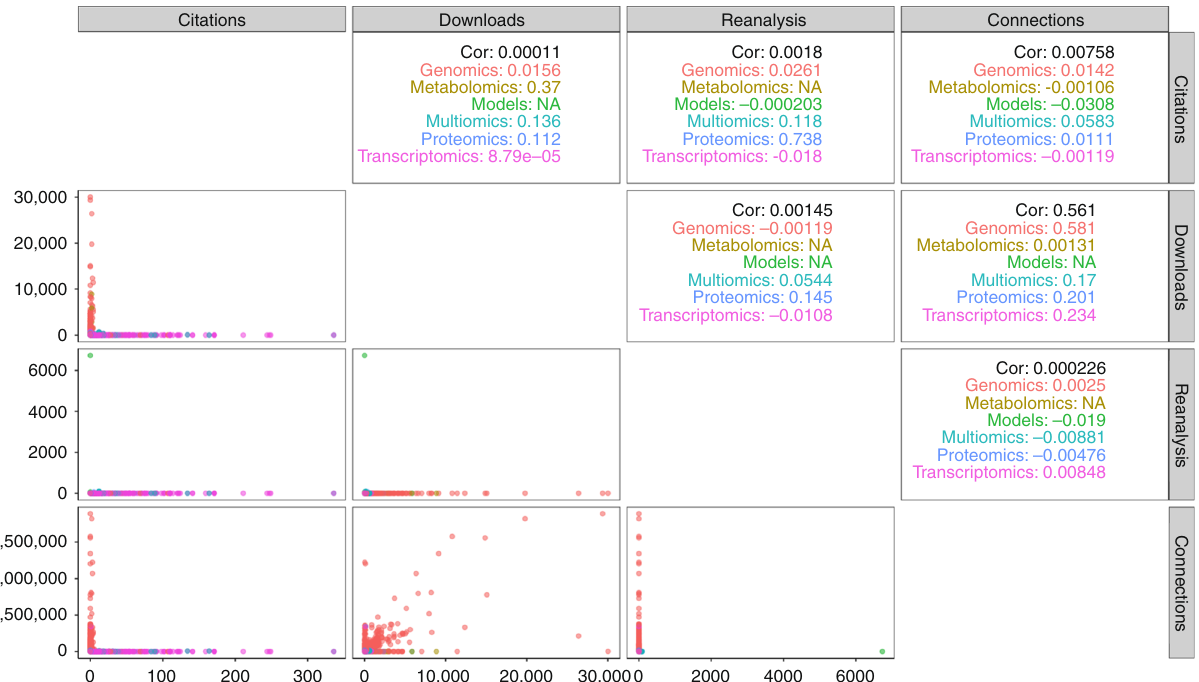
Fig. 3 Correlation between the OmicsDI metrics (reanalyses, citations, downloads and connections) and omics type (proteomics, genomics, transcriptomics, metabolomics and multiomics). The lower left panels show the scatter plots of each combination and the upper right panels shows the values for each type of omics. For example, the number of downloads and the number of connections of Genomics datasets (red) is highly correlated ( R = 0.5) compared to all other metrics